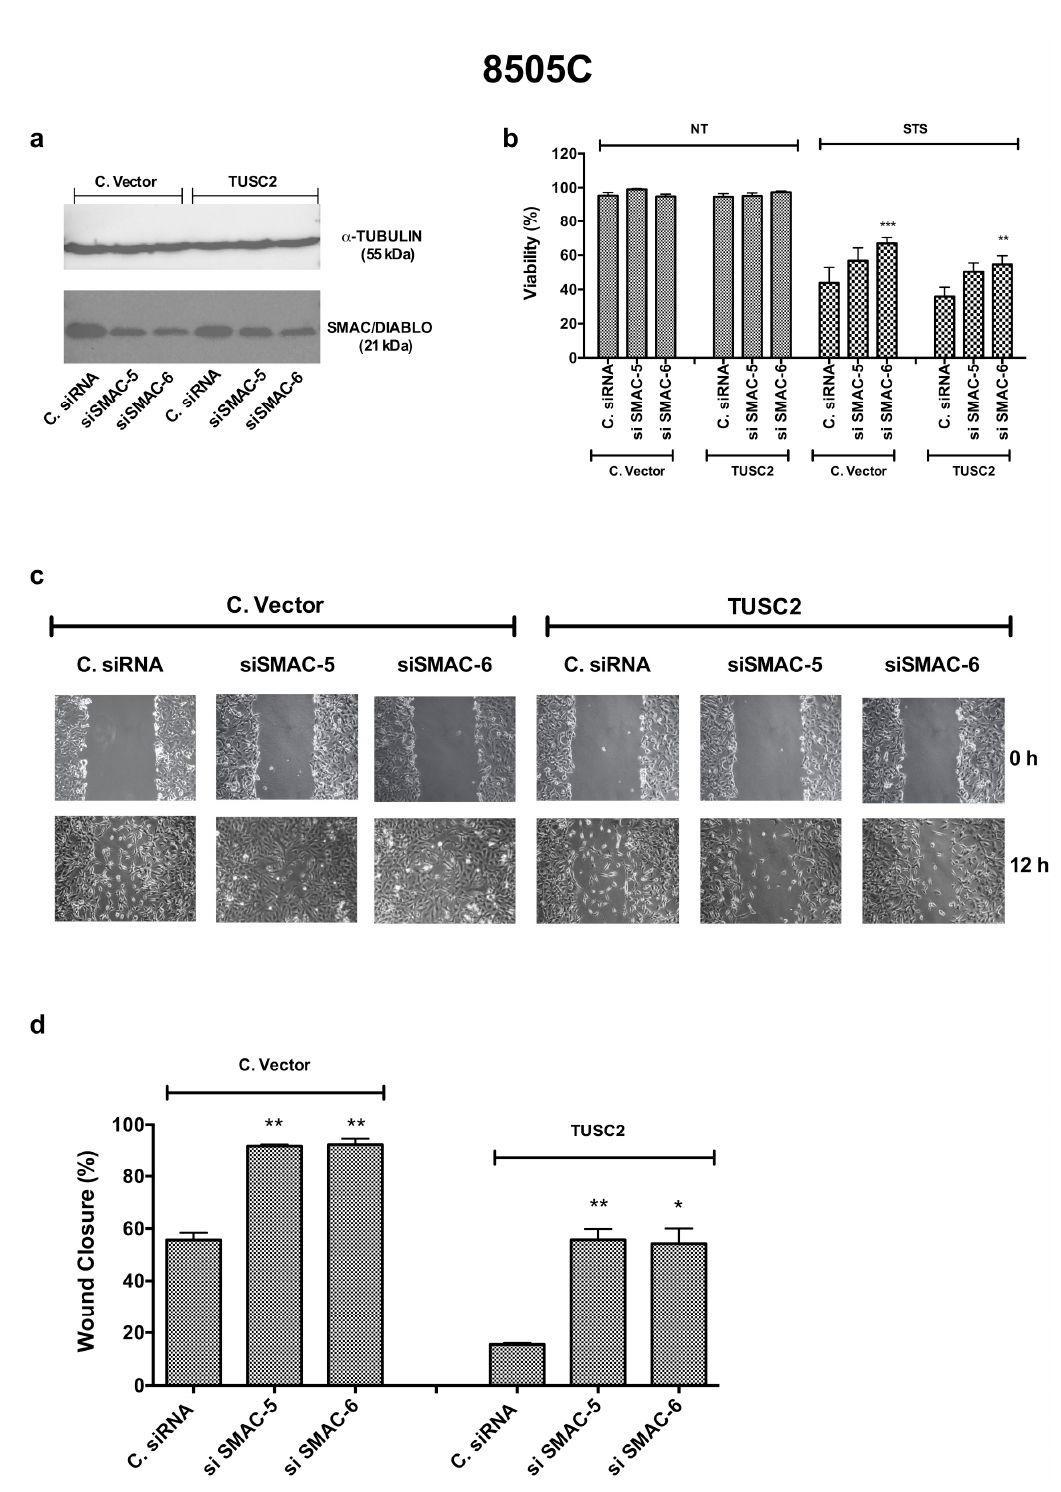
Figure 7. Silencing SMAC/DIABLO partially rescues the TUSC2-induced phenotype in the 8505C cell line. ( a ) 8505C/C. vector and 8505C/TUSC2 cells were transiently transfected with two different SMAC/DIABLO siRNAs (siSMAC-5 or siSMAC-6) or with Control siRNA (named C. siRNA). After 72 h, protein lysates were subjected to immunoblotting with the indicated antibodies. ( b ) 8505C/C.